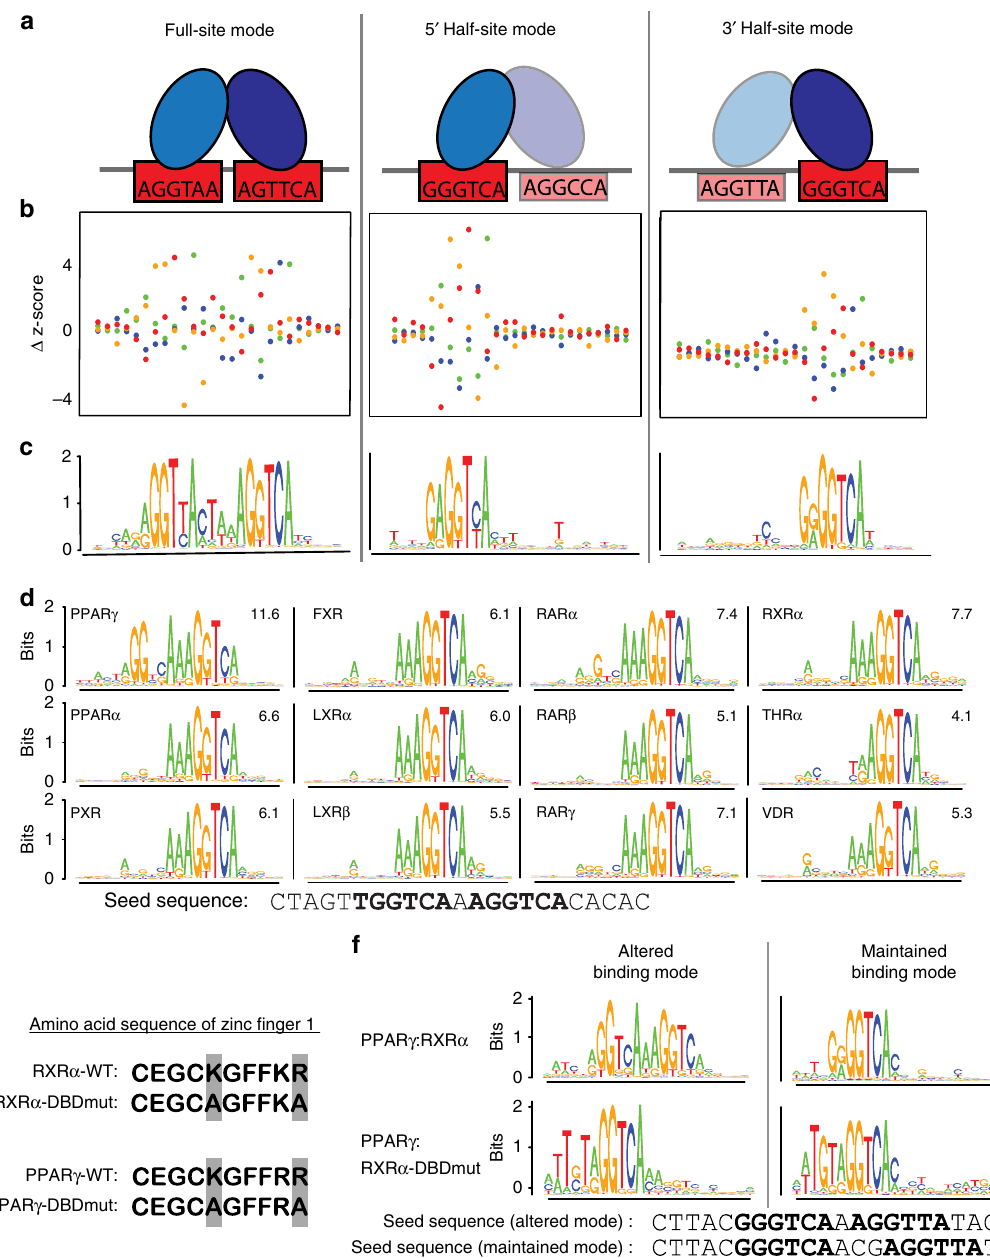
Fig. 3 NR half-site binding mode. a Schematic of NR full-site or half-site binding modes. b , c For three seed sequences bound with different modes, the impact of SNVs on LXR α heterodimer binding and the corresponding DNA-binding logos are shown. Binding perturbation for each SNV is shown as a Δ z- score from the median z-score of all four base variants at each position. Colors correspond to base identity indicated in logos below. d DNA-binding logos for all 12 NRs generated for the single DR1 seed sequence shown. e Amino acid sequence of zinc fi nger 1 for the wild-type RXR α , RXR α DNA-binding domain mutant, wild-type PPAR γ , and the PPAR γ DNA-binding domain mutant. Altered amino acids are highlighted in gray. f DNA-binding logos for individual seed sequences (shown) for which the binding mode was either altered (left) or maintained (right) for the PPAR γ :RXR α -DNA binding domain mutant. Source data are provided as a Source Data fi Role of monomers in half-site binding . To examine the con- showing that all DNA sites are bound by the mutant as a het- tribution of each protein within an NR heterodimer to DNA erodimer. For PPAR γ -DBDmut:RXR α , PBMs performed using an binding, we created DNA-binding domain mutants (DBDmut) of anti-RXR antibody are dominated by RXR homodimer signal, RXR α and PPAR γ . Two residues within zinc fi nger 1 of RXR α therefore binding of PPAR γ -DBDmut:RXR α was determined and PPAR γ that make base-speci fi c contact with DNA were using only the anti-PPAR γ antibody. RXR α homodimer binding mutated to alanines (K156A and R161A; and K132A and R137A, was not observed in wild-type heterodimer experiments (see respectively, Fig. 3e) 31 . Binding of PPAR γ :RXR α -DBDmut is above). All DBD mutant proteins were produced by IVT and highly correlated using either anti-RXR α or anti-PPAR γ anti- PBM data for IVT-produced wild-type dimers agree with bodies (R 2 of antibody replicates given in Supplementary Data 1), experiments using puri fi ed proteins, demonstrating that IVT